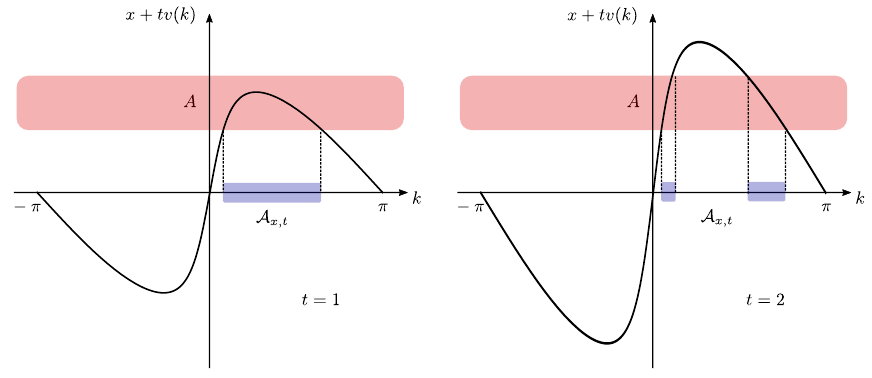
Figure 1: Pictorial representation of the bipartition induced in the auxiliary Hilbert space H . On the horizontal axis we consider the momenta within the first Brillouin x zone, on the vertical axis we consider the function x + tv ( k ) . We focus on two differ- ent times. We consider a bipartition in the real space A ∪ B with A an interval in the vertical axis, which is then prolongated in the whole red-shaded area. The domain A (blue-shaded area) in the momentum space is determined by those momenta x , t such that x + tv ( k ) lays within the interval A